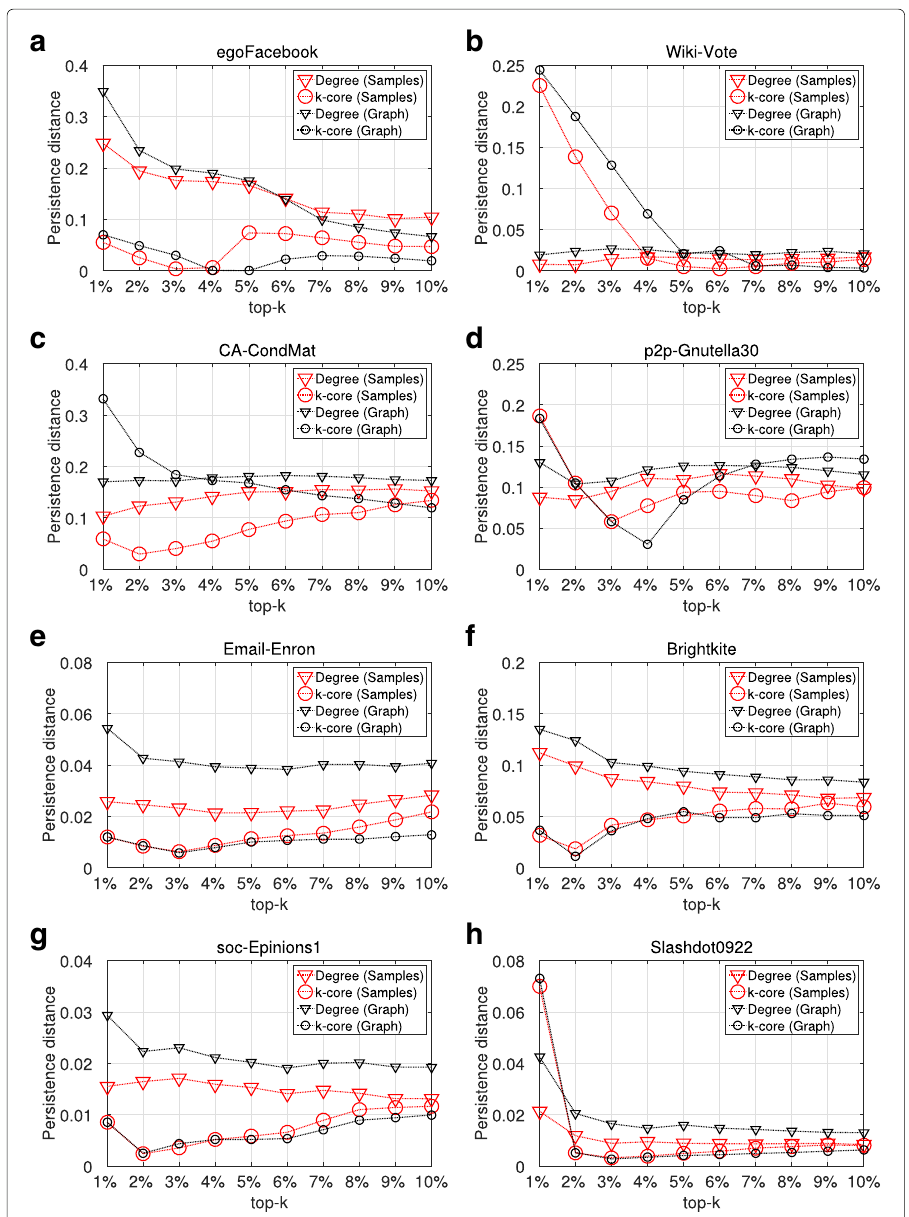
Fig. 2 Top-k spreading efficiency, SIS epidemic. a - h Persistence-distances in terms of degree centrality and k-core obtained from maxRD samples, as well as from the original